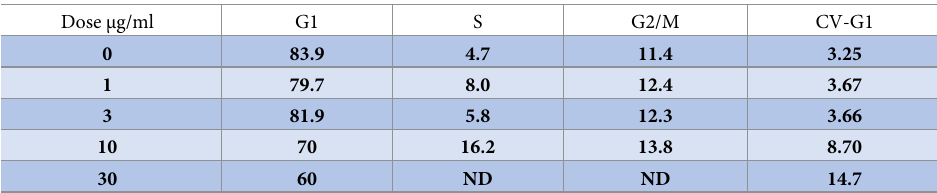
Table 3. Cell cycle phases of